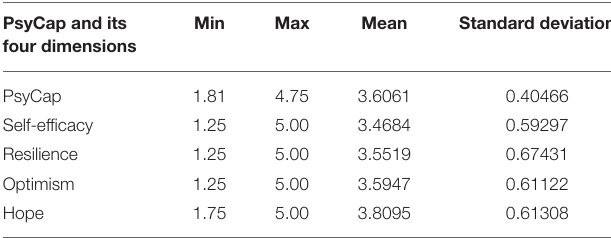
TABLE 7 | Empirical results for PsyCap and its four